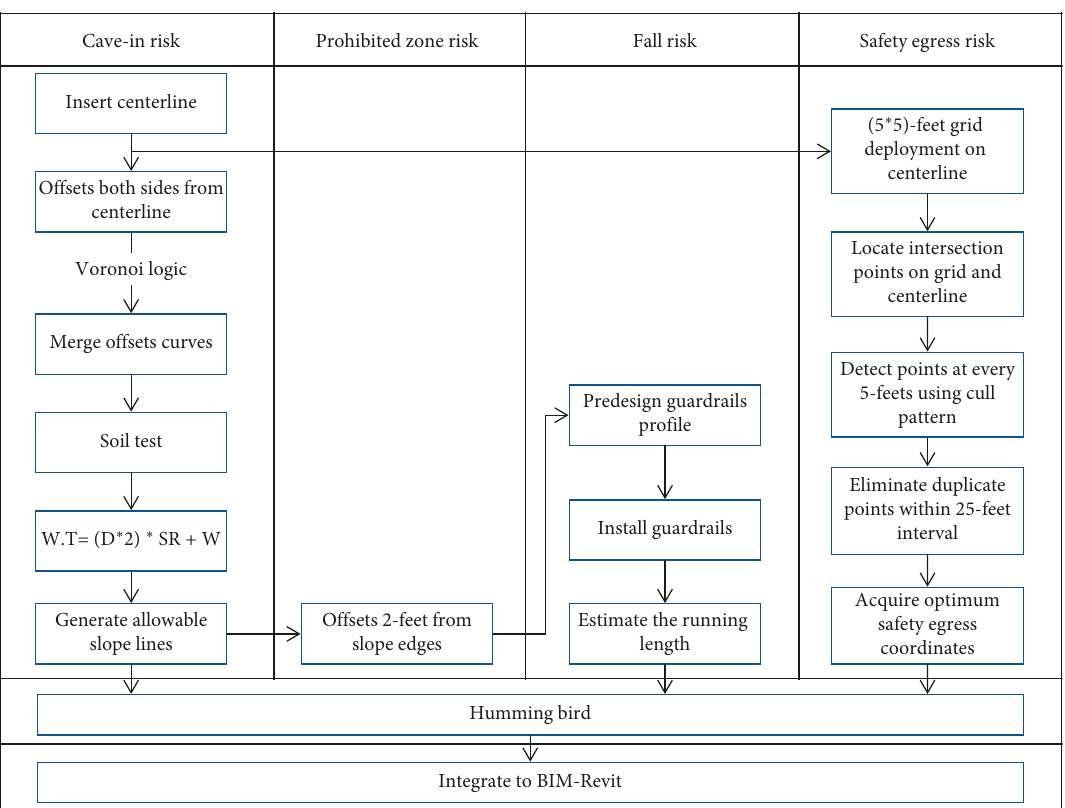
Figure 3: Visual algorithm development swimlane diagram.